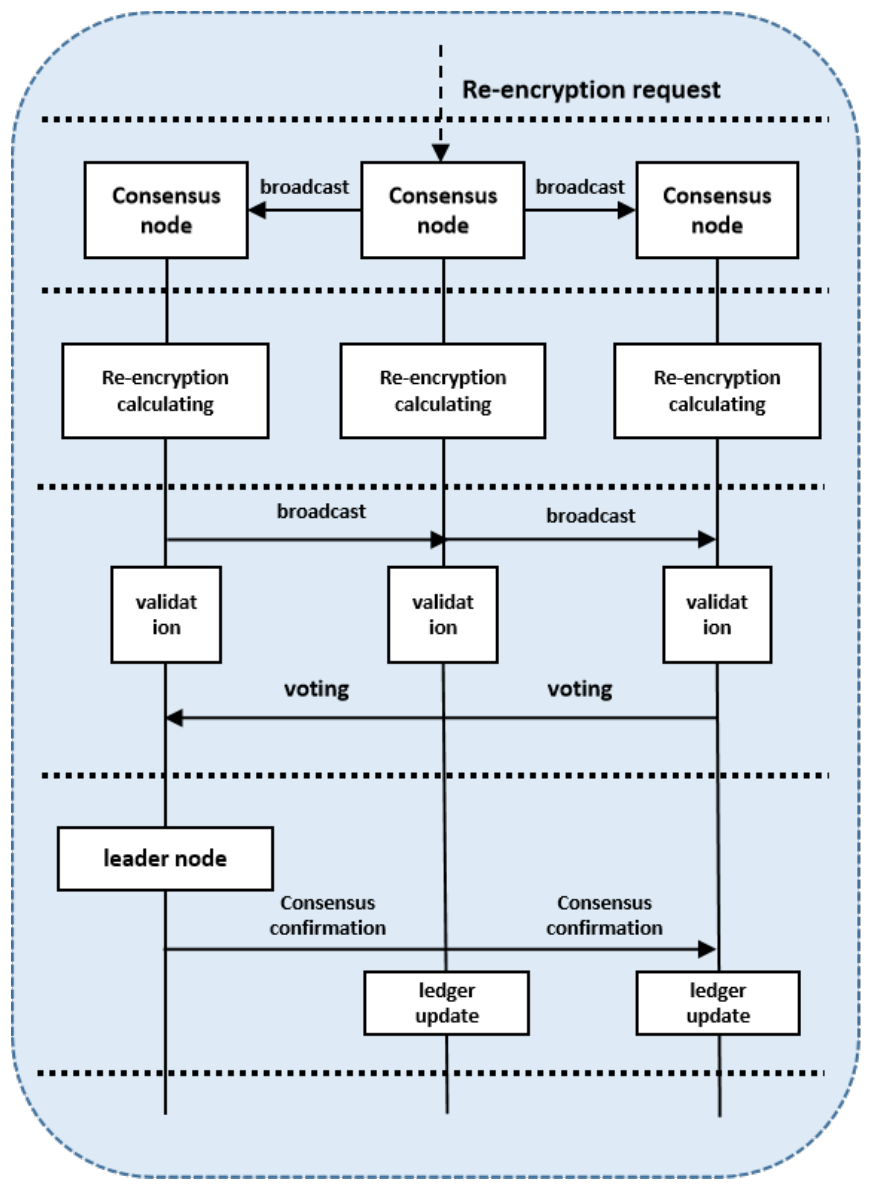
Figure 5. The workflow of data re-encryption processing and consensus